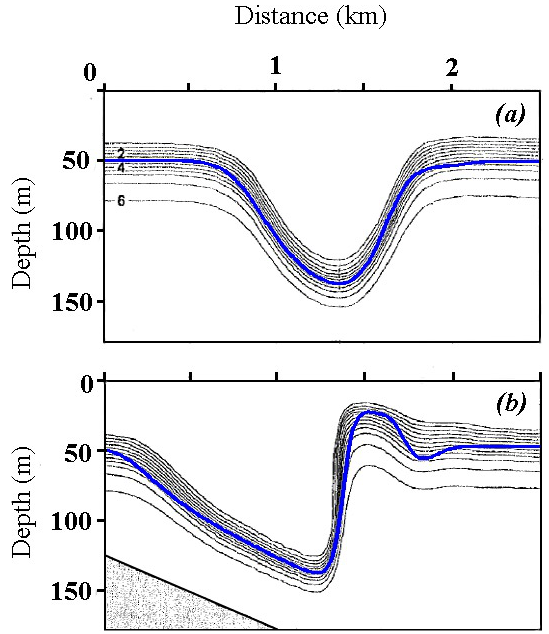
Fig. 7. Shoaling internal wave over a slope (tan α = 0 . 05). The wave moves to the left. Comparison of numerical results from Vlasenko and Hutter (2002) (thin lines, Fig. 2a and b) with the numerical so- lution of (1) (bold line). Corresponding wave parameters are given in the